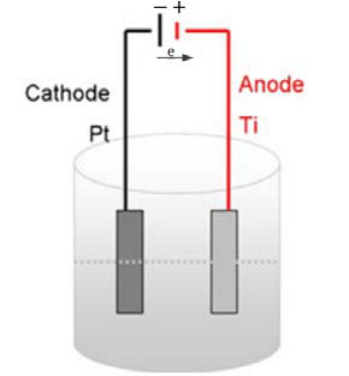
Figure 1. Basic setup for the anodization of titanium to titania nanotubes. Reprinted with permission from